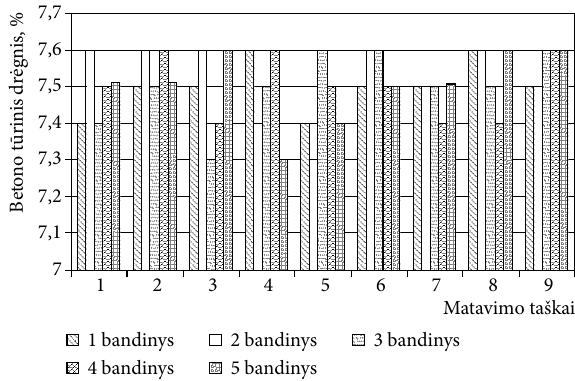
6 pav. D1 serijos sudėties betono vidutinio tūrinio drėgnio matavimų sklaida penkiuose kubeliuose bandymo metu Fig. 6. The spread of the measurements of the average moisture content of D1 series concrete in five cubes at the final stage of